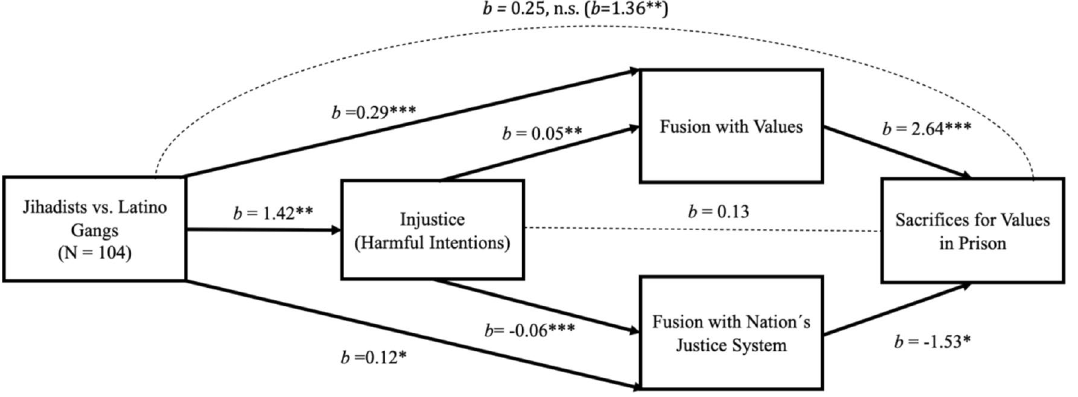
Figure 4. Mediation analysis showing: (1) jihadists express more feelings of perceived injustice in sentencing than do gang members; (2) their feelings of injustice increase willingness to sacrifice for values by increasing fusion with values; (3) lessening levels of perceived injustice increases fusion with the nation’s justice system, which in turn reduces willingness to sacrifice for (religious) values. b values are unstandardized β values; * p < .05; ** p < .01; *** p < .001. Total effect: b = 1.36, 95% CI [0.53, 2.20]. Direct effect: b = 0.24, 95% CI [− 0.48, 0.99]. Indirect effects: Group > Injustice > Sacrifices: b = 0.19, 95% CI [− 0.06, 0.56]; Group > Fusion values > Sacrifices: b = 0.78, 95% CI [0.30, 1.38]; Group > Fusion justice system > Sacrifices: b = − 0.19, 95%CI [− 0.52, − 0.01]; Group > Injustice > Fusion values > Sacrifices: b = 0.20, 95%CI [0.05, 0.44]; Group > Injustice > Fusion justice system > Sacrifices: b = 0.13, 95% CI [0.02,